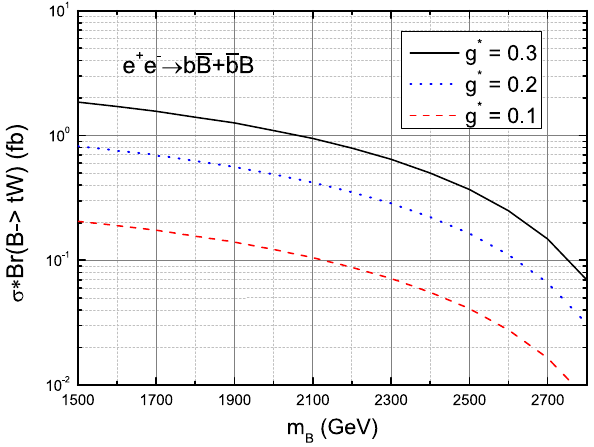
Fig. 2 Totalcrosssectionsasafunctionof m B withthreetypicalvalues of g ∗